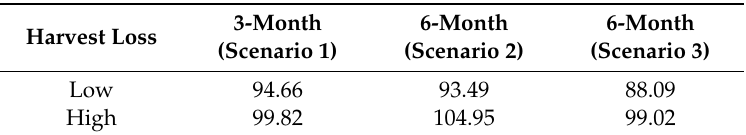
Table 10. Average cost (USD / Mg) of feedstock purchased at the SSL for achieved annual biorefinery operation (high productivity / fertilizer requirement).